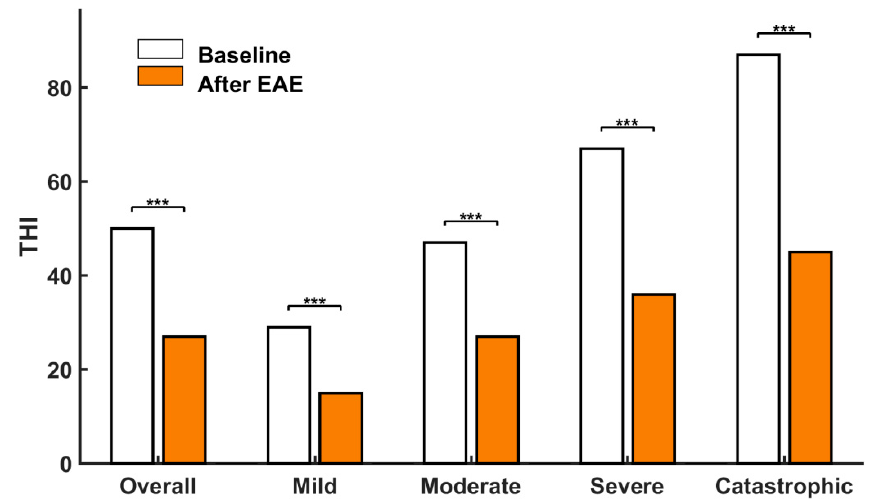
Figure 9. Average THI scores before and after treatment for the different distress groups. *** represents statistical significance at p < 0.001.